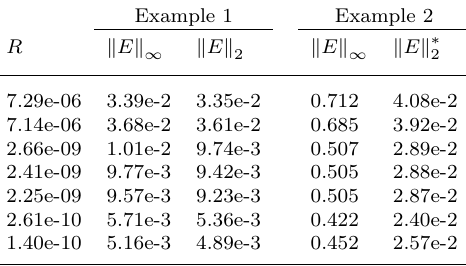
Table 4. Monotonicity analysis of local minima using the reflection coefficient R Example 1 Example 2